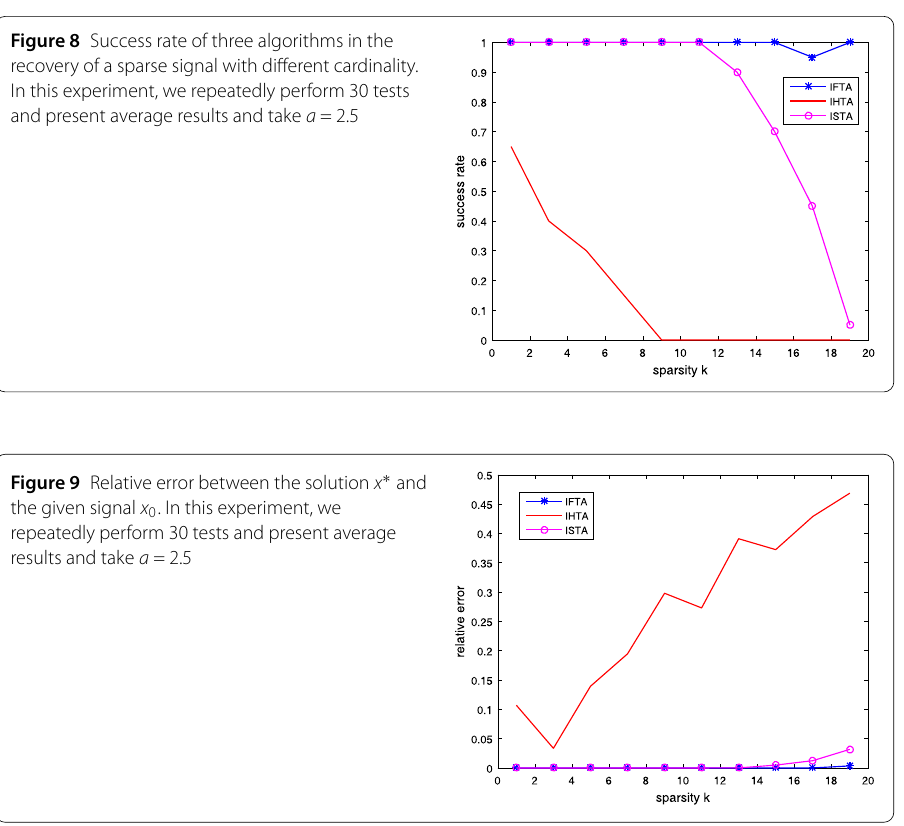
Figure 8 Success rate of three algorithms in the recovery of a sparse signal with different cardinality.